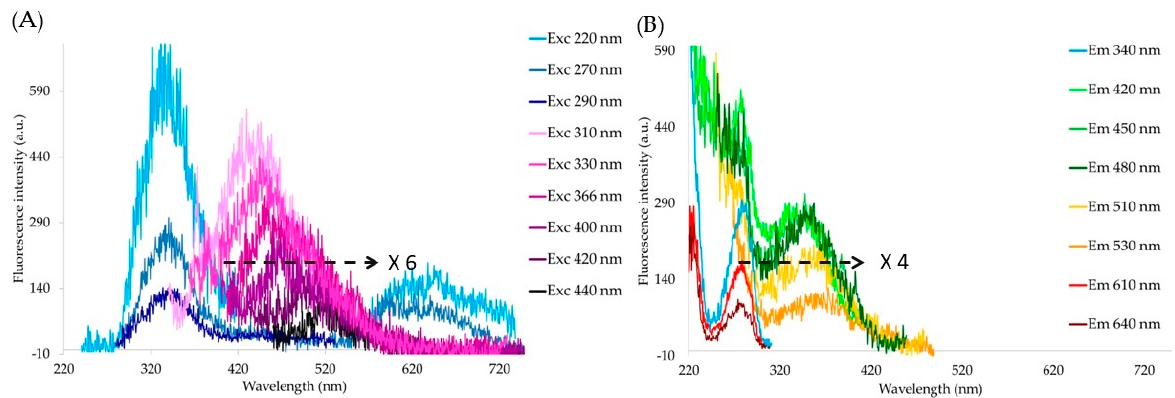
Figure 6. Emission ( A ) and excitation ( B ) spectra recorded from the preparation extract from mosquito eggs. To allow the spectral shapes of the spectra covering the 320–620 nm range ( A ) and the 300–520 nm range ( B ) to be better appreciated, their amplitudes are increased with respect to the fluorescence intensity scale a.u. values as indicated by the arrow in each panel. Excitation and emission conditions are indicated by colors on the right.